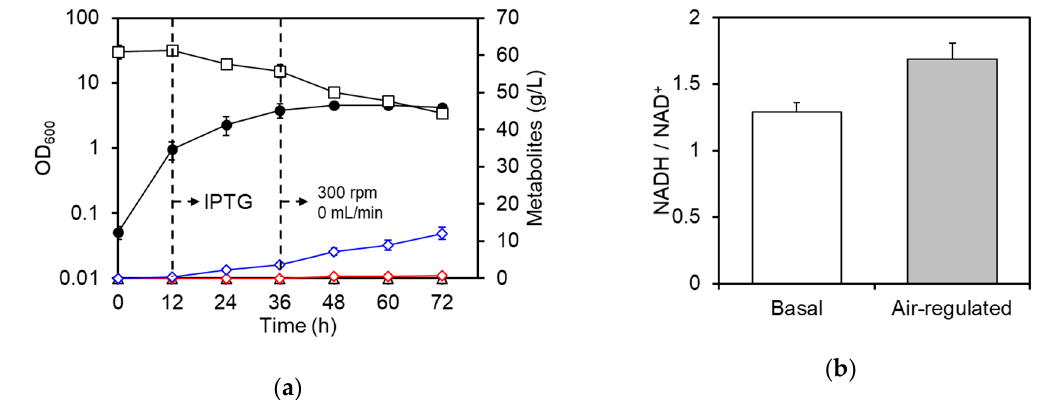
Figure 4. d -Lactate production under air-regulated conditions. The values of aeration parameters were changed at 36 h (central vertical dashed line) from 1800 rpm and 150 mL · min − 1 to 300 rpm and 0 mL · min − 1 , respectively. ( a ) The culture profile of the LAC strain and ( b ) NADH / NAD + ratio for cultures grown under the basal (white) and the air-regulated (gray) conditions. Symbols: filled circles, OD600; squares, glucose; triangles, acetate; red diamonds, pyruvate; blue diamonds, d -lactate. The data shown are the mean ± SD at 72 h ( n = 3); values in ( b ) are at 72 h.